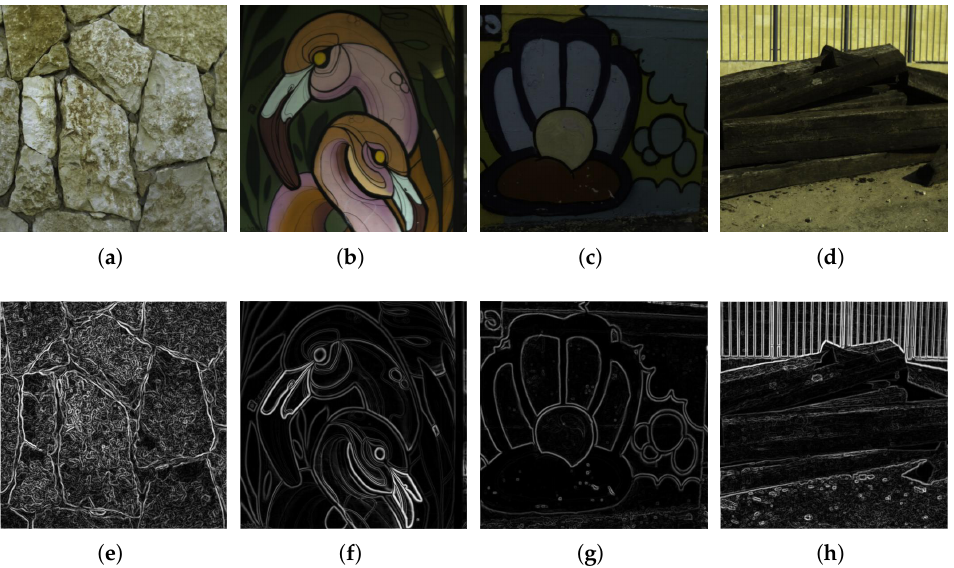
Figure 4. The first row ( a – d ) shows several original images from the NTIRE2020 dataset. The second row ( e – h ) displays the effect of edge extraction and the white lines represent boundary